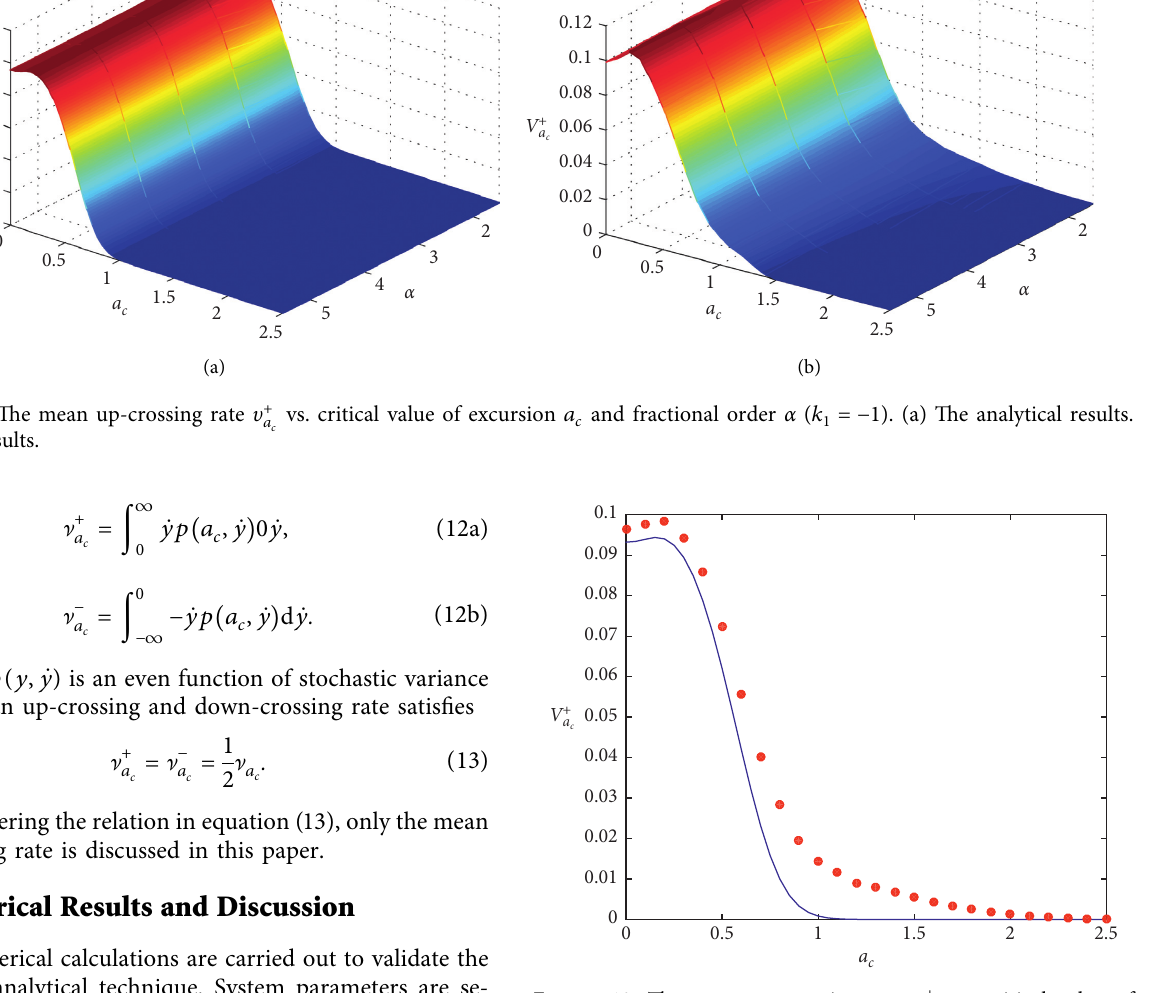
a c vs. critical value of � − 1, solid lines: the analytical 1